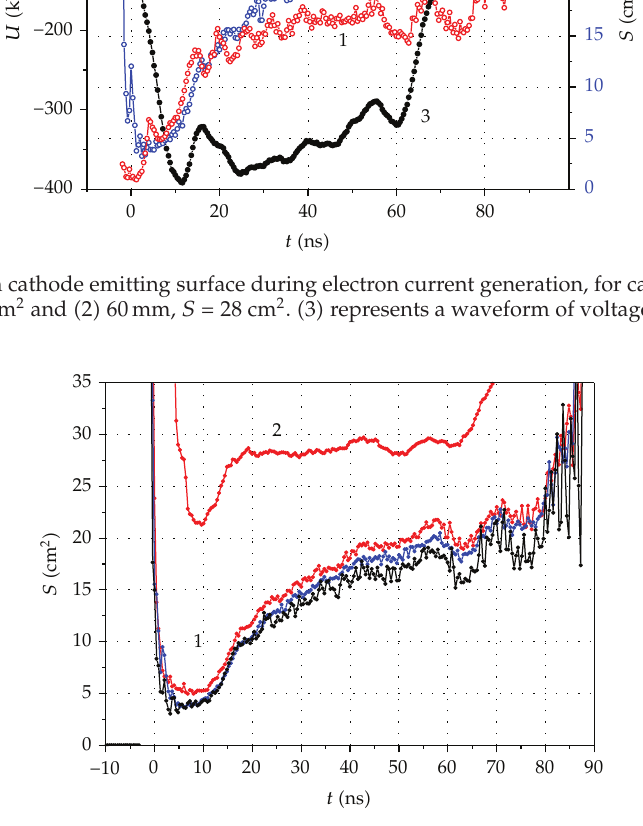
L load is parasitic load inductance 240 nH. Calculation of the inductance was made from the ratio for a straight conductor at a frequency of 1–10 MHz (cid:4) 25 (cid:5) . We investigated a planar diode (cid:2) 4.5 cm × 22 cm (cid:3) with a graphite potential electrode (cid:2) the cathode during the first